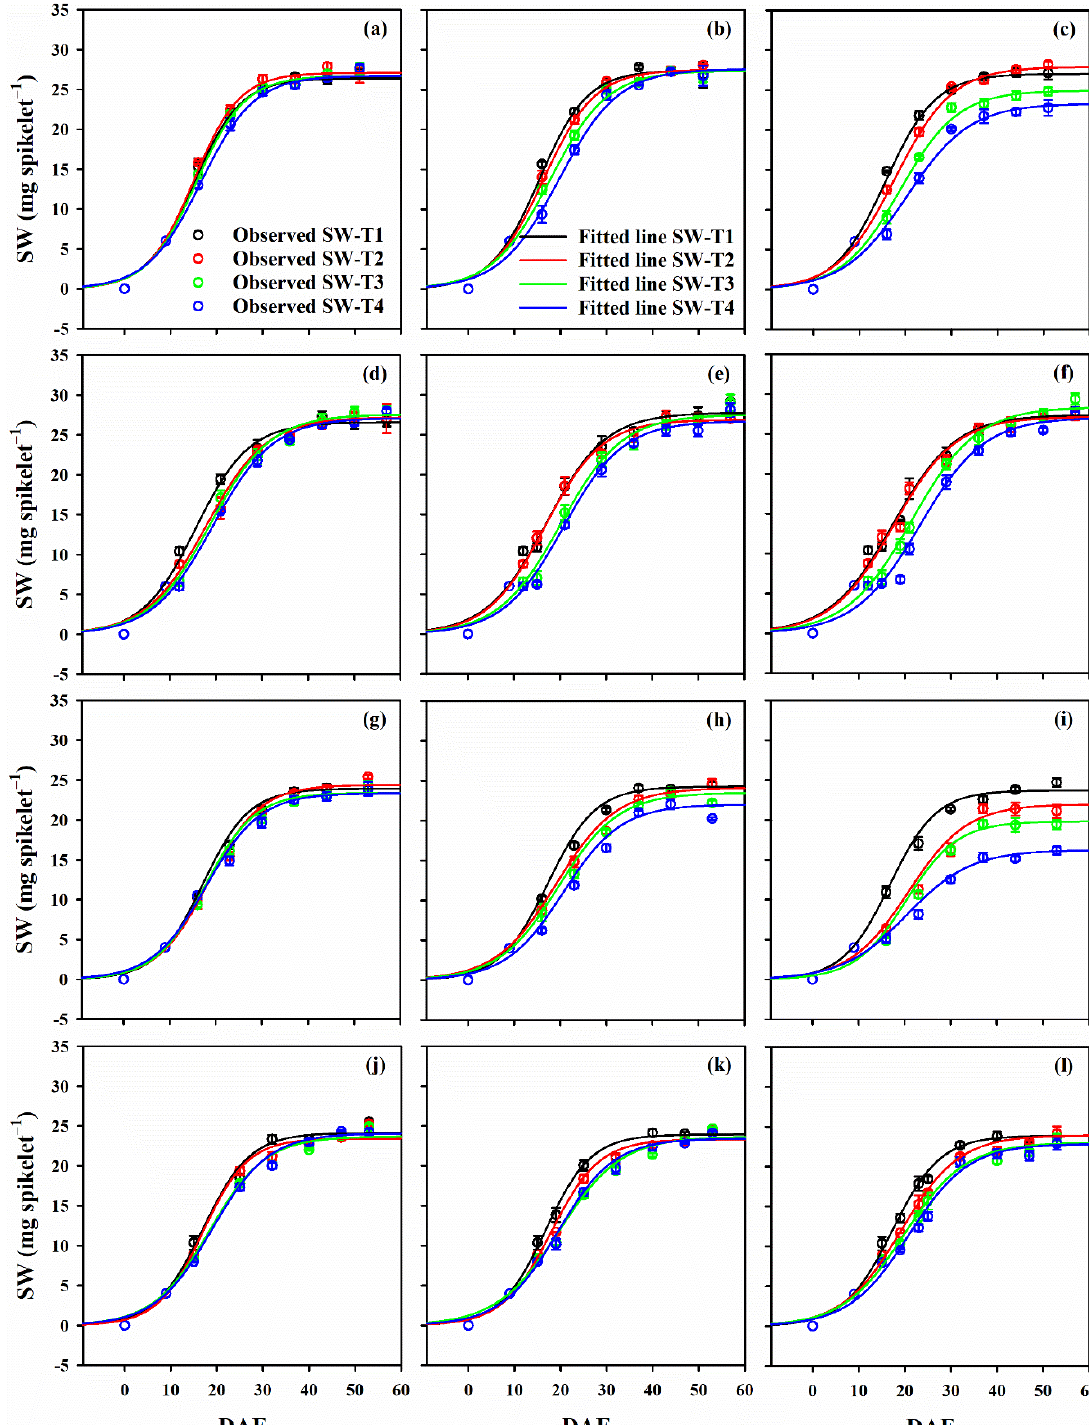
Figure 1. The sigmoid relationship of days after flowering (DAF) with spikelet weight (SW) in Huaidao 5 (capital letters panels) and Nanjing 46 (small letters panels) under low-temperature stress (LTS) at the flowering stage ( a – c ) and ( g – i ) grain filling stage ( d – f ) and ( i – l ) stages. The T min /T max at T1, T2, T3 and T4 were 21/27, 17/23, 13/19 and 9/15 °C, respectively. Graph ( a , d , g , j ), ( b , e , h , k ) and ( c , f , i , l ) represent LTS durations of 3, 6 and 9 days, respectively. Bars on each symbol show the standard error of means. Observed values of SW m were fitted against DAF using regression analysis.